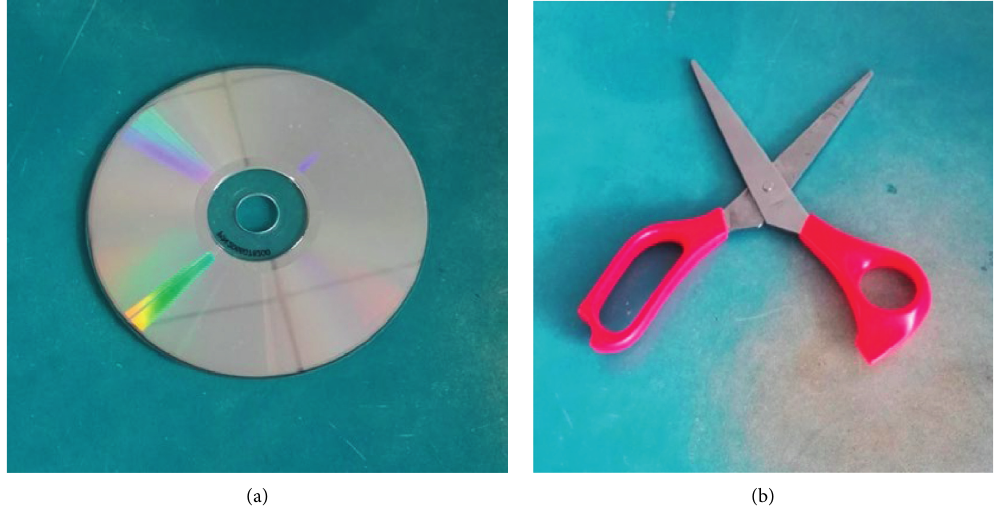
Figure 6: Targets for imaging experiments: (a) disc; (b) scissors.